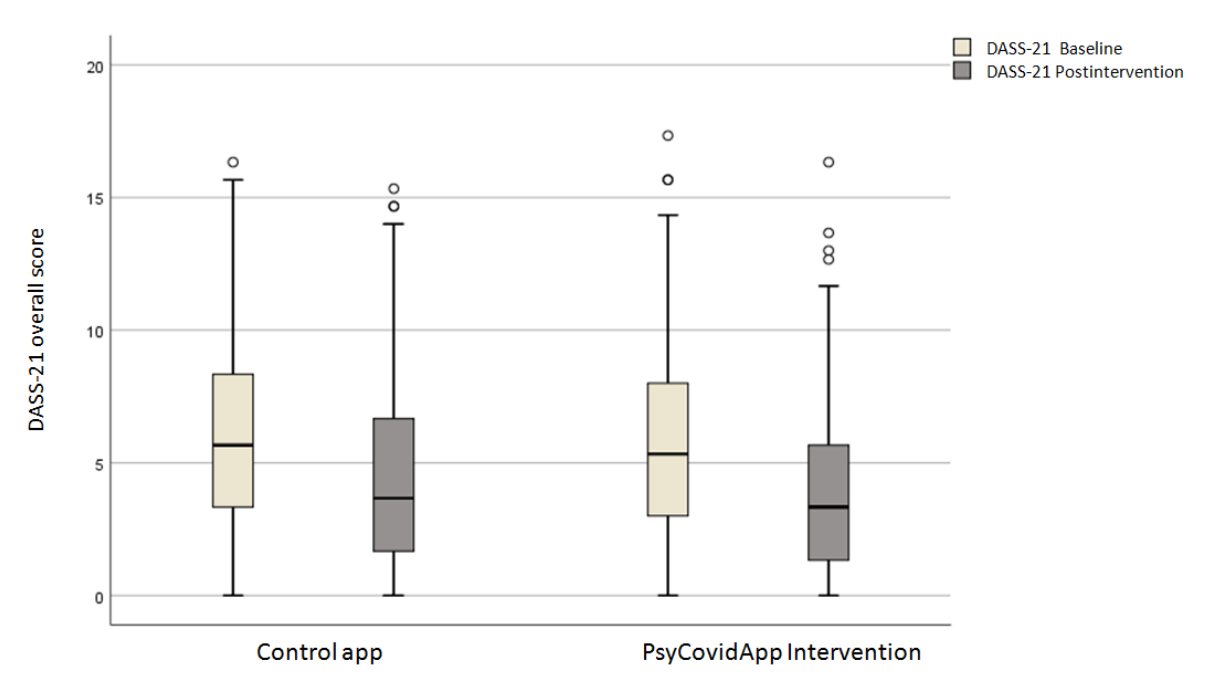
Figure 2. Changes in median DASS-21 scores over time, with the raw data plot of the median DASS-21 scores. Baseline scores were recorded before